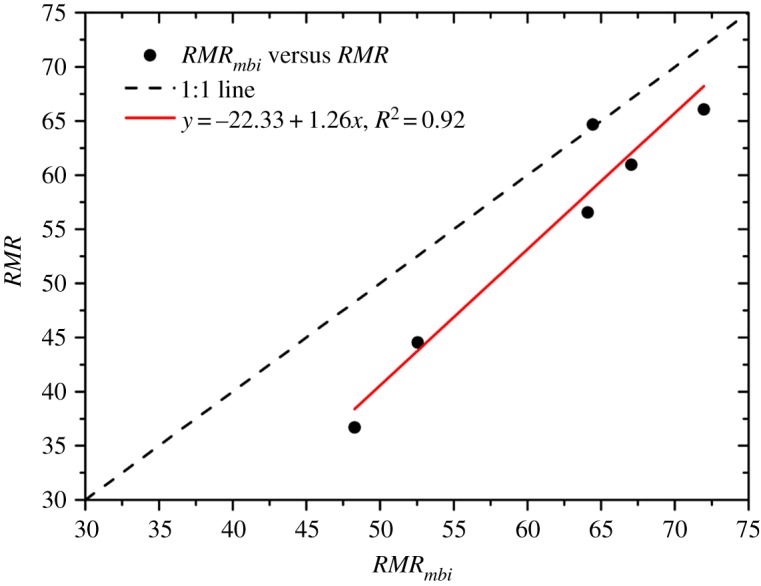
Comparison between RMRmbi and RMR (real data).